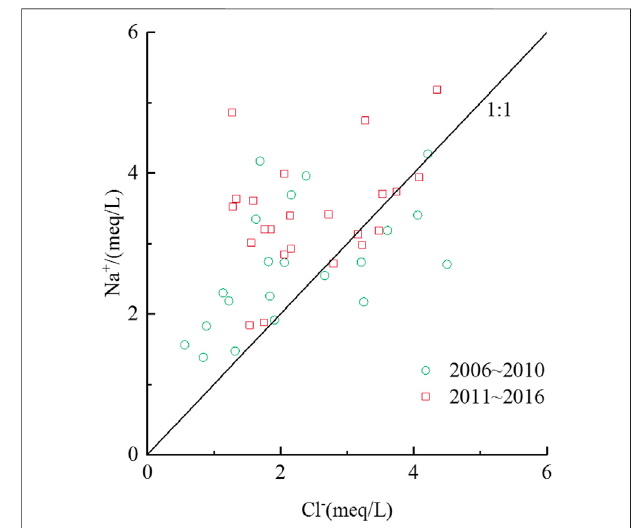
FIGURE 5 | Ratio of Na + to Cl −